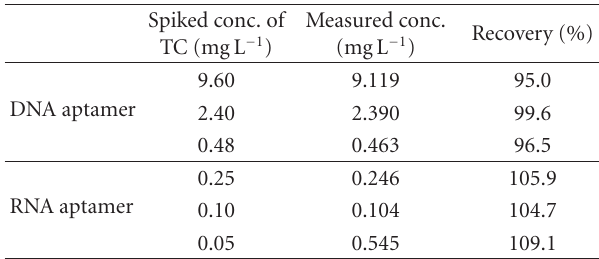
Table 2: Recovery study for the determination of TC spiked in milk. Spiked conc.